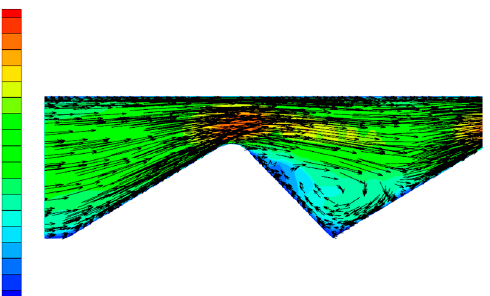
Figure 8. Laminar flow pressure nephogram. Figure 9. Turbulent flow pressure nephogram. Figure 6 shows that when the polymer solution flows through the throttling section, although the flow direction changes, each layer of fluid maintains its own flow state, does not interfere with the other layers, and maintains a laminar flow state. However, as shown in Figure 7, when the velocity of the polymer solution increases, the fluid layers cannot maintain their respective flow states, the laminar flow state is destroyed, and there is sliding and mixing between the adjacent flow layers, eventually forming turbulent flow. The degree of perturbation of the polymer solution is greatest at the lowest point of the flow channel. By considering the dissipation effect [26,27] and the turbulent perturbation theory [28], it is concluded that the turbulence intensity generated by the flow disturbance and the energy loss of the solution are largest in the partial pressure tool. Figures 8 and 9 are pressure nephograms of the polymer solution flowing in the partial pressure tool under laminar and turbulent states. Under the laminar flow state, the pressure change of the polymer solution is relatively uniform. Under the turbulent flow state, at the place in the tool where the perturbation zone is generated, the pressure suddenly becomes smaller upstream of the perturbation zone and becomes larger downstream of the perturbation zone, causing an uneven change in the pressure of the polymer solution, which causes the overall pressure in the tool to drop. This is consistent with the analysis of the dissipation effect described above. The development of turbulence accelerates the energy consumption of the polymer solution compared with the laminar flow. The pressure drop is larger than the laminar flow, so it is very important to study the transition from laminar to turbulent flow of the polymer solution in the partial pressure tool.